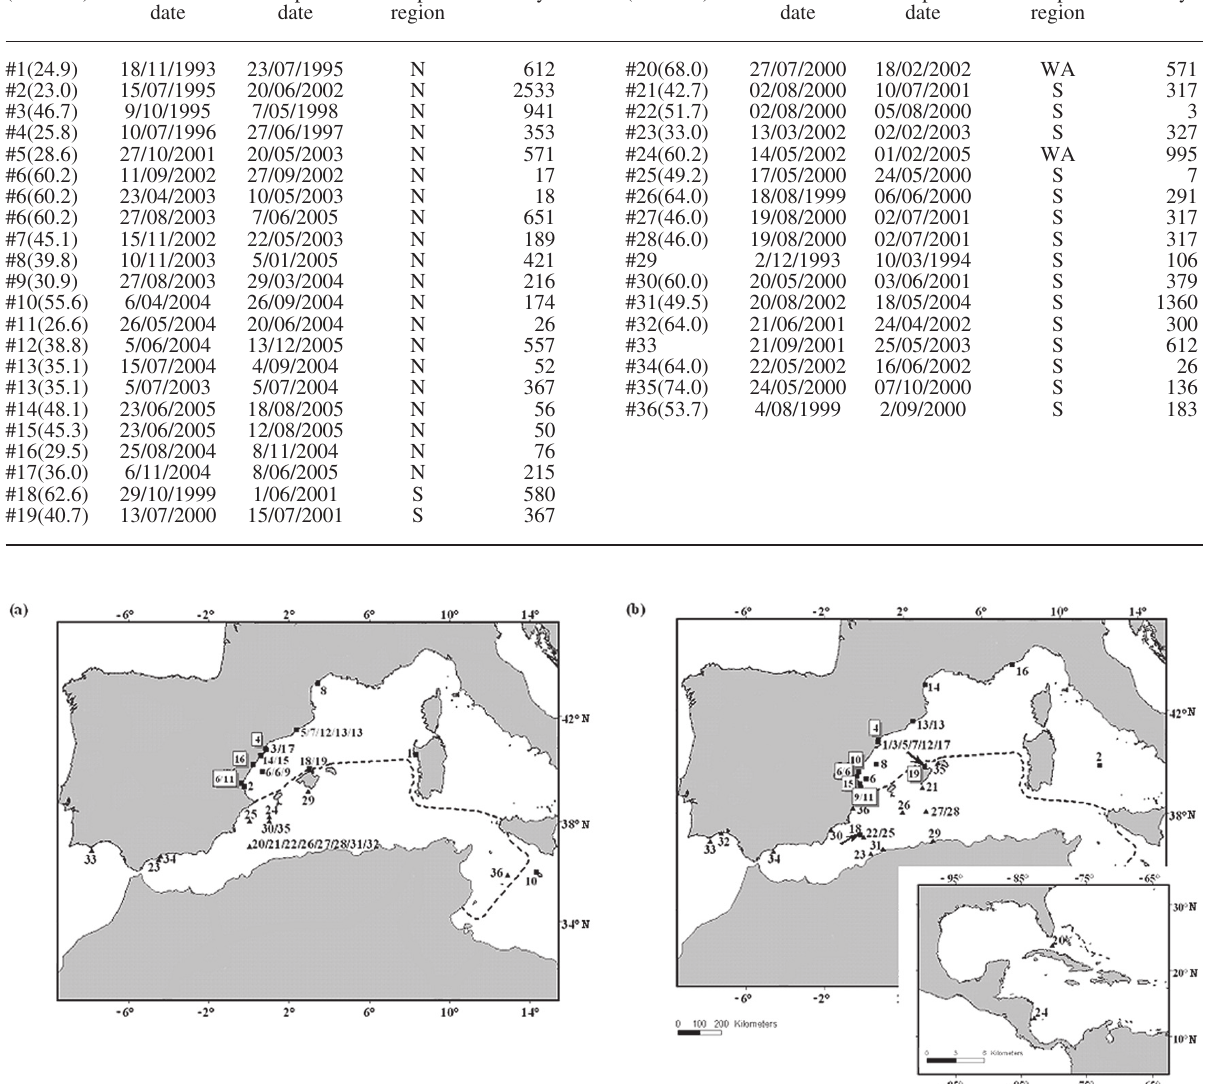
Table 1. – Loggerhead sea turtles tagged and recaptured in the northern and southern regions of the western Mediterranean. N, northern region; S, southern region; WA, western Atlantic. Turtle